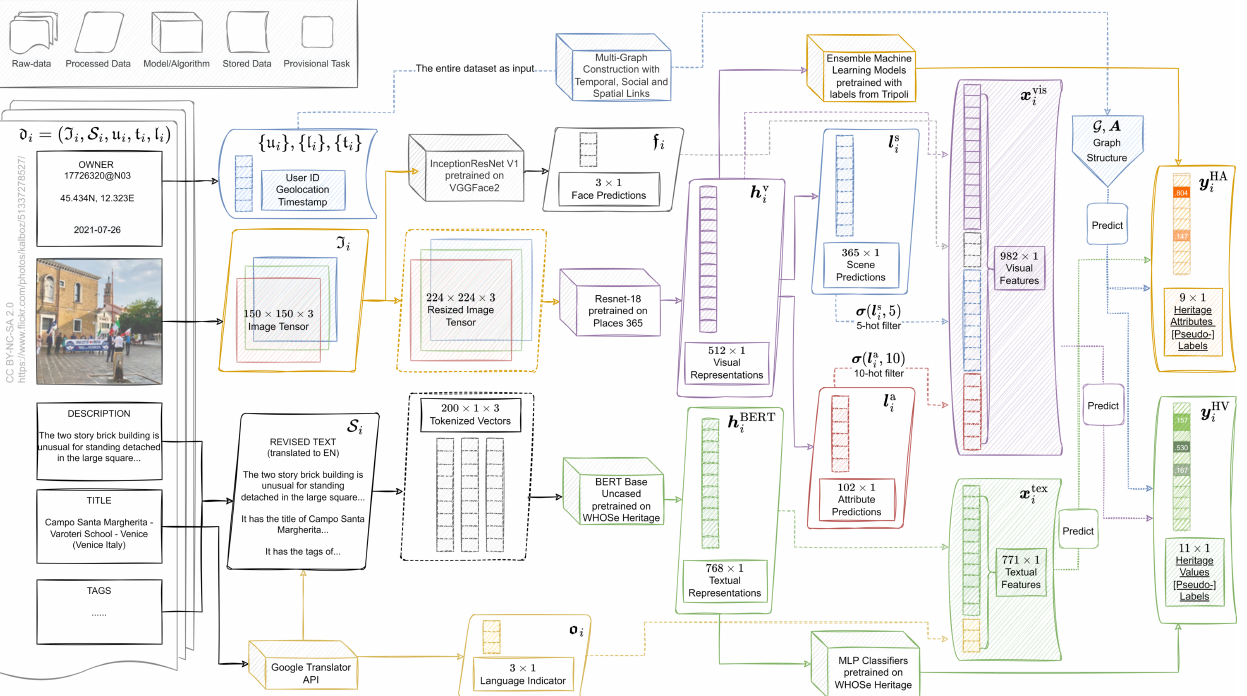
Figure 2. Data flow of the multi-modal feature generation process of one sample post in Venice, while graph construction requires all data points of the dataset. The original post owned by user 17726320@N03 is under CC BY-NC-SA 2.0